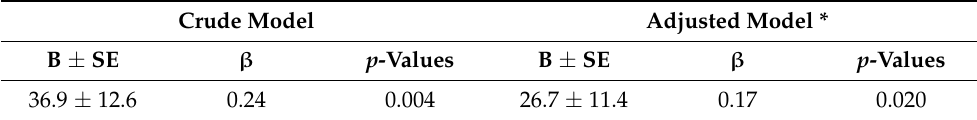
Table 3. Linear regression analysis between SOB and